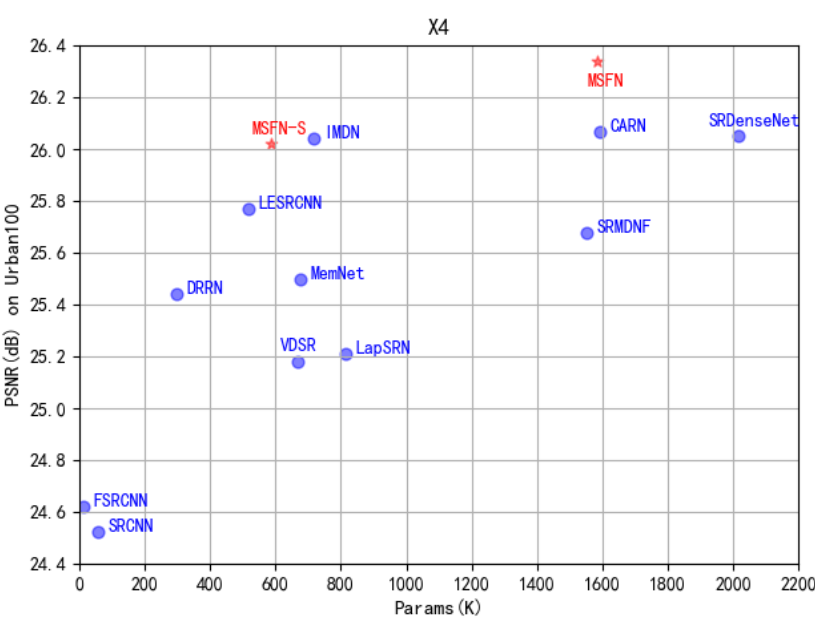
Figure 1. Trade-off between reconstruction performance and parameters on Urban100 with scaling factor